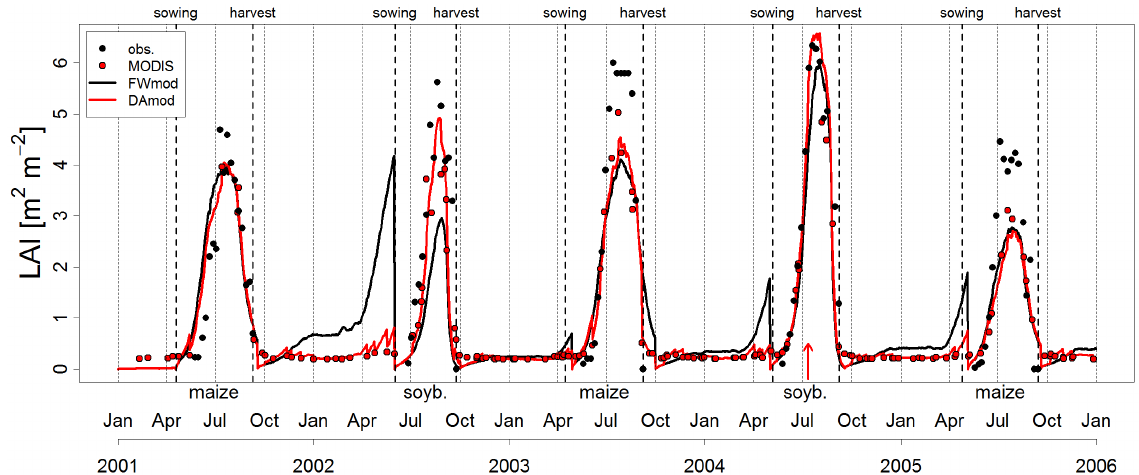
Fig. 5. Observed (black circles), MODIS-derived (red circles), and modelled LAI (experiments FWmod and DAmod, black and red lines) for the Bondville EC flux tower site, 2001–2006. The vertical dashed lines denote farmer reported sowing and harvest dates for the flux site. The red arrow in July 2004 denotes the location of maximum MODIS-derived LAI ( ∼ 9 . 1m 2 m − 2 , not shown in figure).